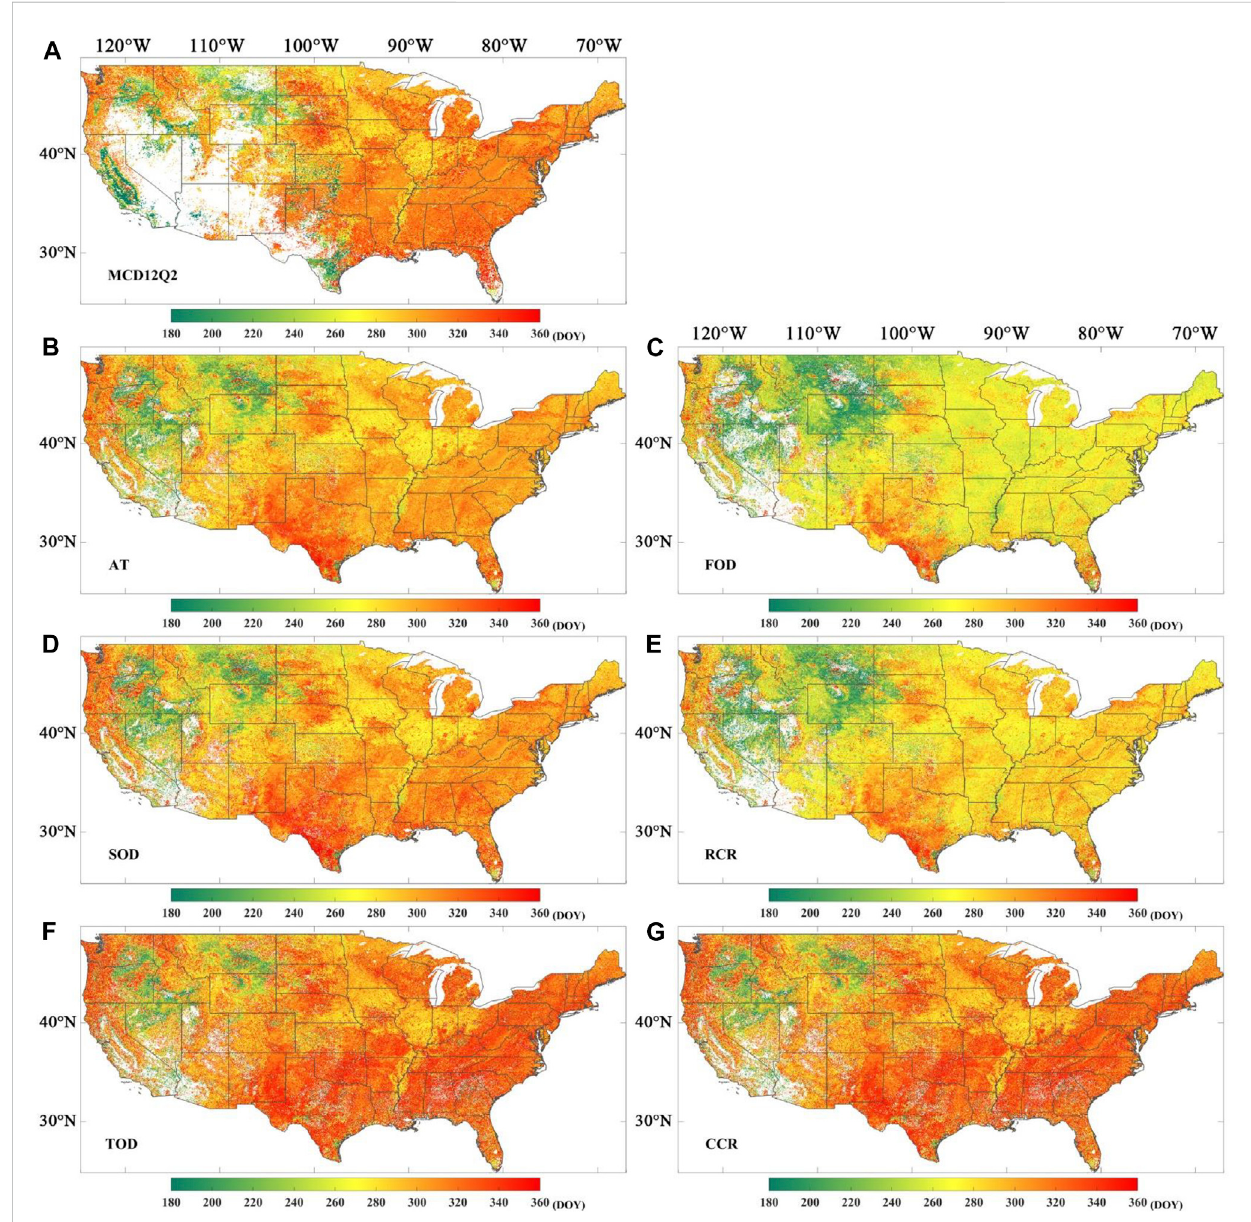
FIGURE 7 Spatial distribution for the end of season (EOS) in 2017. (A) EOS obtained from MCD12Q2; (B) EOS derived from MOD09Q1 EVI2 time series by amplitude threshold (AT); (C) EOS derived from MOD09Q1 EVI2 time series by fi rst-order derivative (FOD); (D) EOS derived from MOD09Q1 EVI2 time series by second-order derivative (SOD); (E) EOS derived from MOD09Q1 EVI2 time series by relative change rate (RCR); (F) EOS derived from MOD09Q1 EVI2 time series by third-order derivative (TOD); (G) EOS derived from MOD09Q1 EVI2 time series by curvature change rate